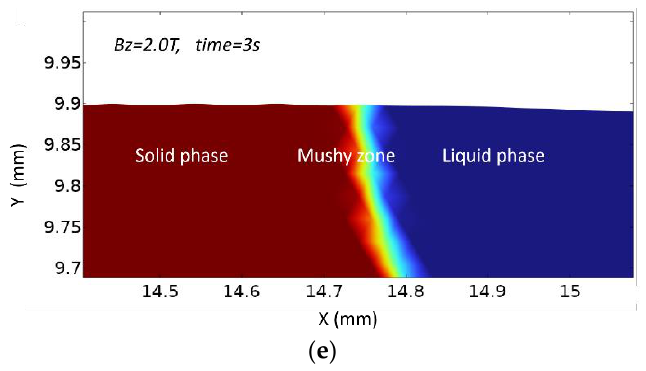
Figure 10. Evolution of solidification surface topography under different magnetic fields. ( a ) Bz =